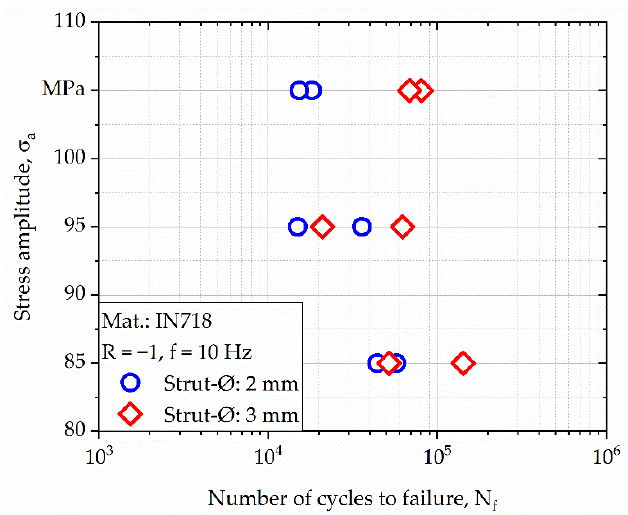
Figure 11. Results of constant amplitude tests (CATs) depicted in form of a typical Woehler-type S–N plot.